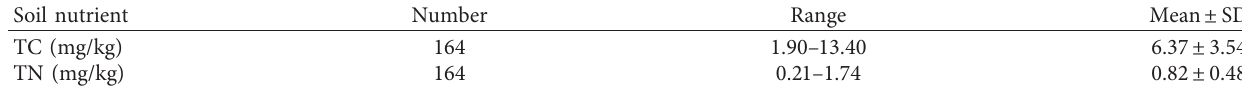
Table 1: Soil sample TC and TN